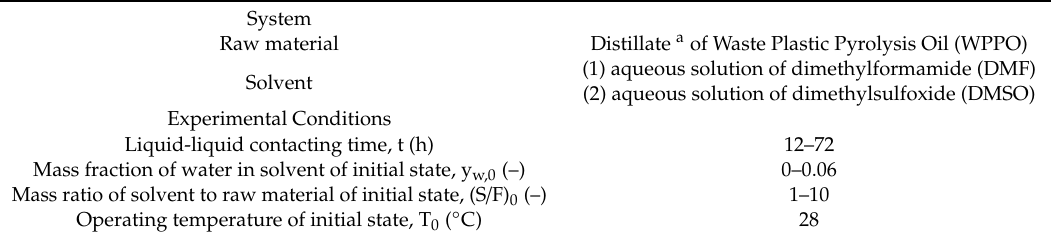
Table 1. Material system and experimental